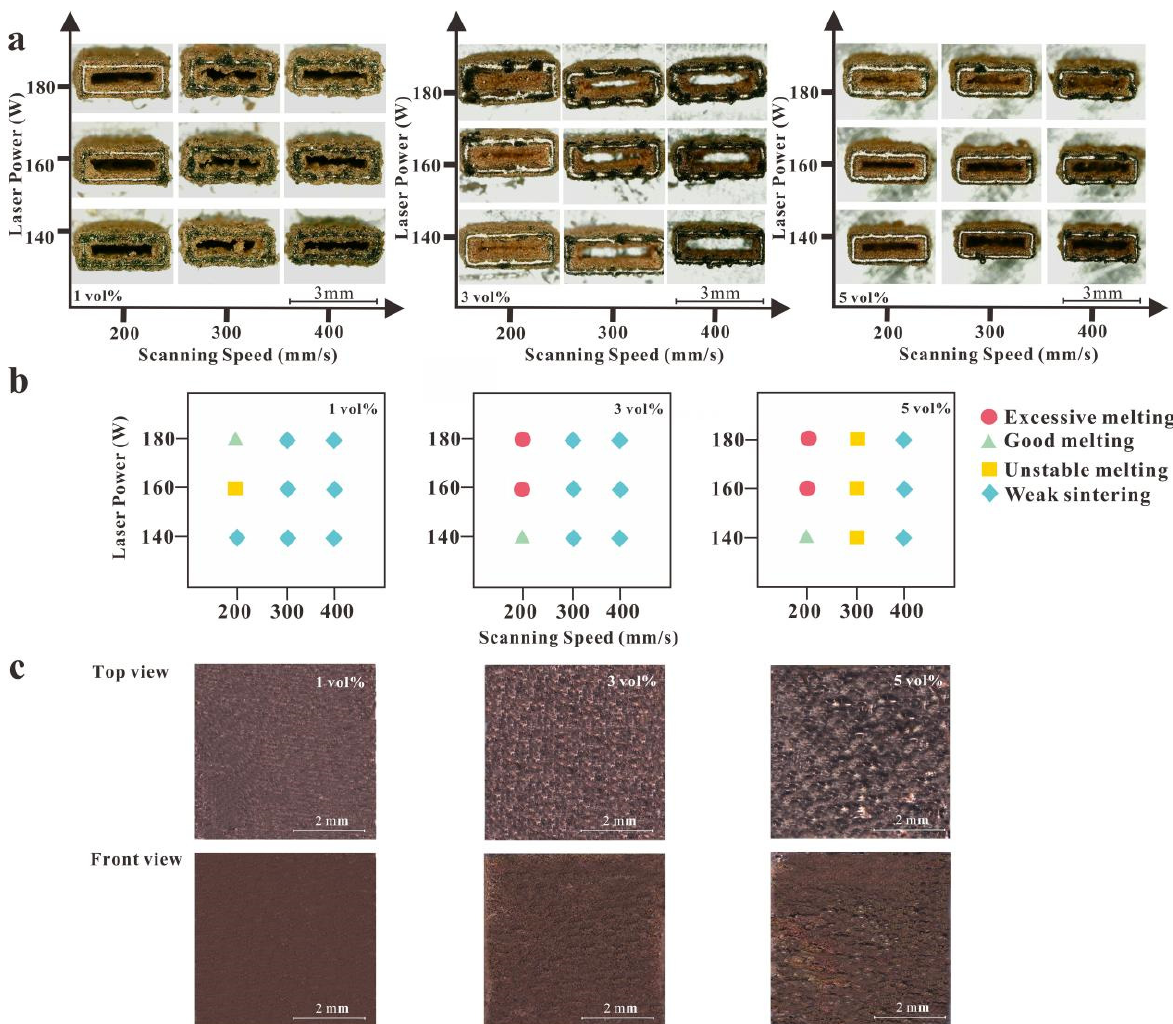
Figure 3. ( a ) Rectangular contour samples of the 1, 3 and 5 vol.% titanium-coated diamond/copper composites; ( b ) the corresponding processing window of the laser power and scanning rate; ( c ) The SLM manufactured morphology: top and front view of the 1, 3 and 5 vol.% titanium-coated dia- mond/copper composite, respectively.